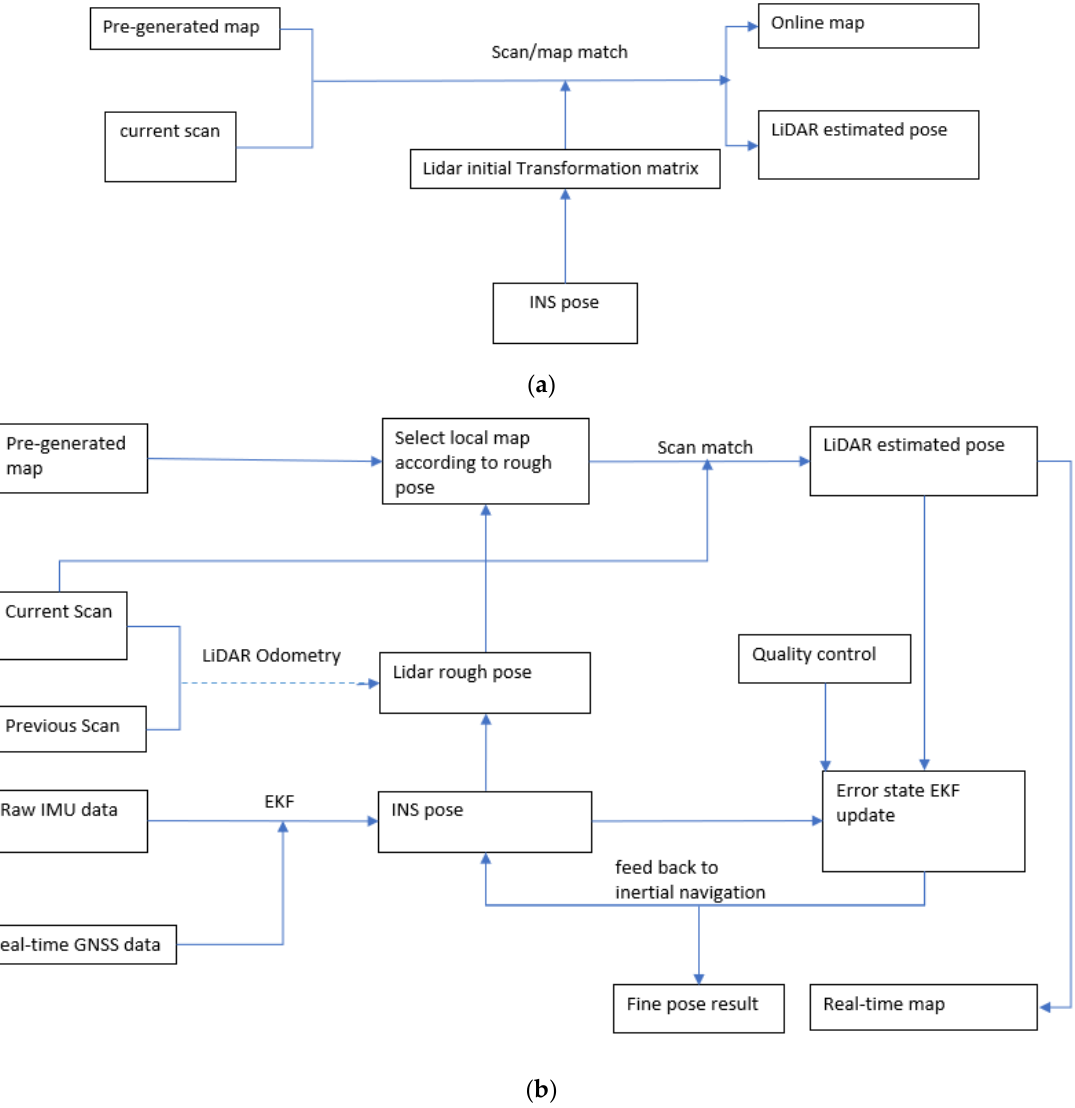
Figure 13. Overview of the proposed Lidar/3D map matching based localization system architecture. ( a ) Method 1: fusing IMU as an assistant sensor; ( b ) Method 2: fusing IMU using the EKF-based tightly coupled